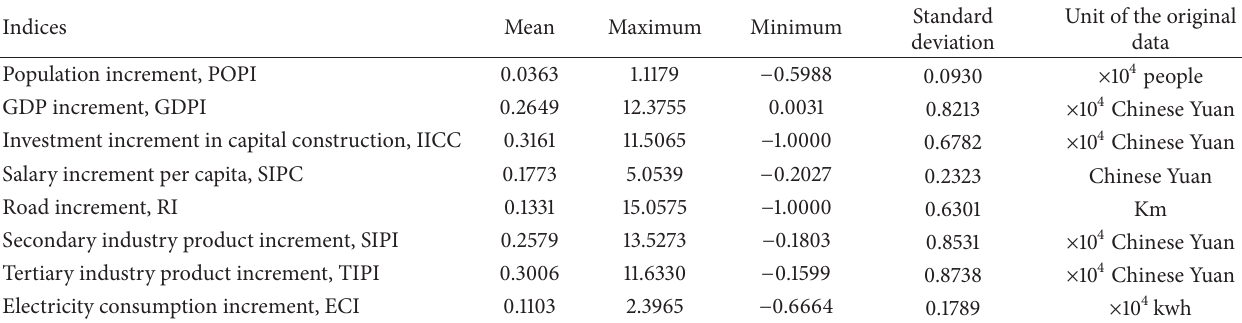
Table 1: Statistics summary of driving factors of urban expansion in 1990–2010 in China.